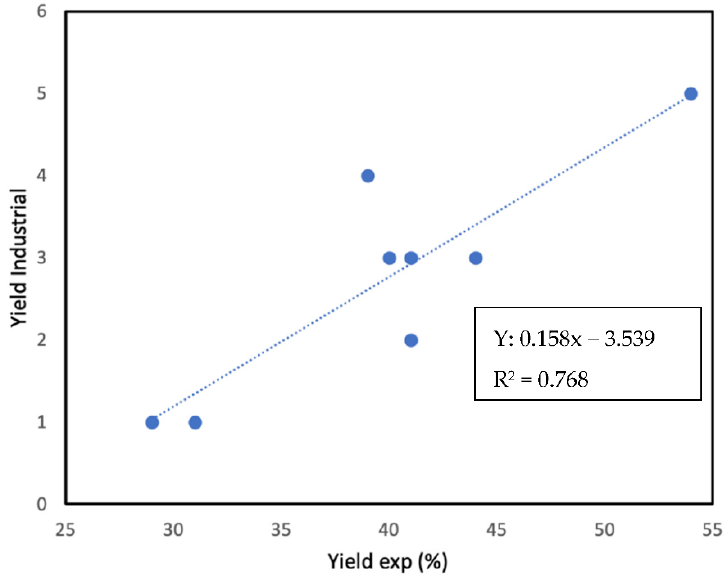
Figure 7. Experimental vs. industrial